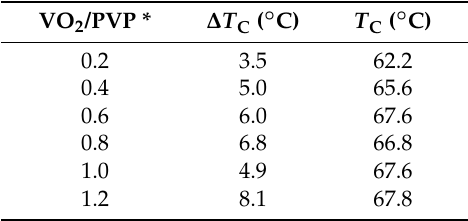
Table 2. Critical transition temperature T C and width of transmittance hysteresis loop ( ∆ T C ) of VO 2 /PVP nanocomposite films for different amounts of